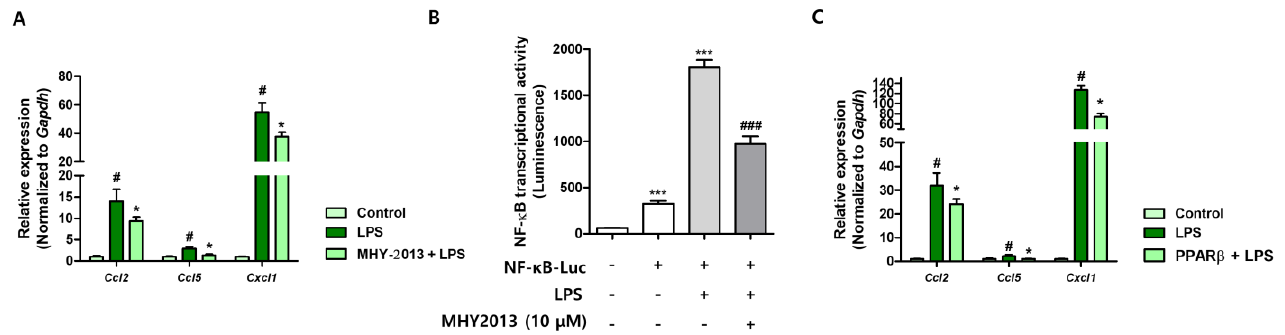
Figure 6. MHY2013 suppresses LPS-induced inflammatory responses in NRK52E cells. ( A ) Relative mRNA levels of inflammation-related genes ( Ccl2 , Ccl5 , and Cxcl1 ) in LPS-treated NRK52E cells with or without MHY2013. # p < 0.05 vs. control group. * p < 0.05 vs. LPS group. ( B ) NF- κ B transcriptional activity was measured under LPS-treated condition with or without MHY2013 treatment. *** p < 0.001 vs. non-treated group. ### p < 0.001 vs. LPS-treated group. ( C ) Relative mRNA levels of inflammation-related genes ( Ccl2, Ccl5 , and Cxcl1 ) in LPS-treated NRK52E cells with or without PPARβ expression.